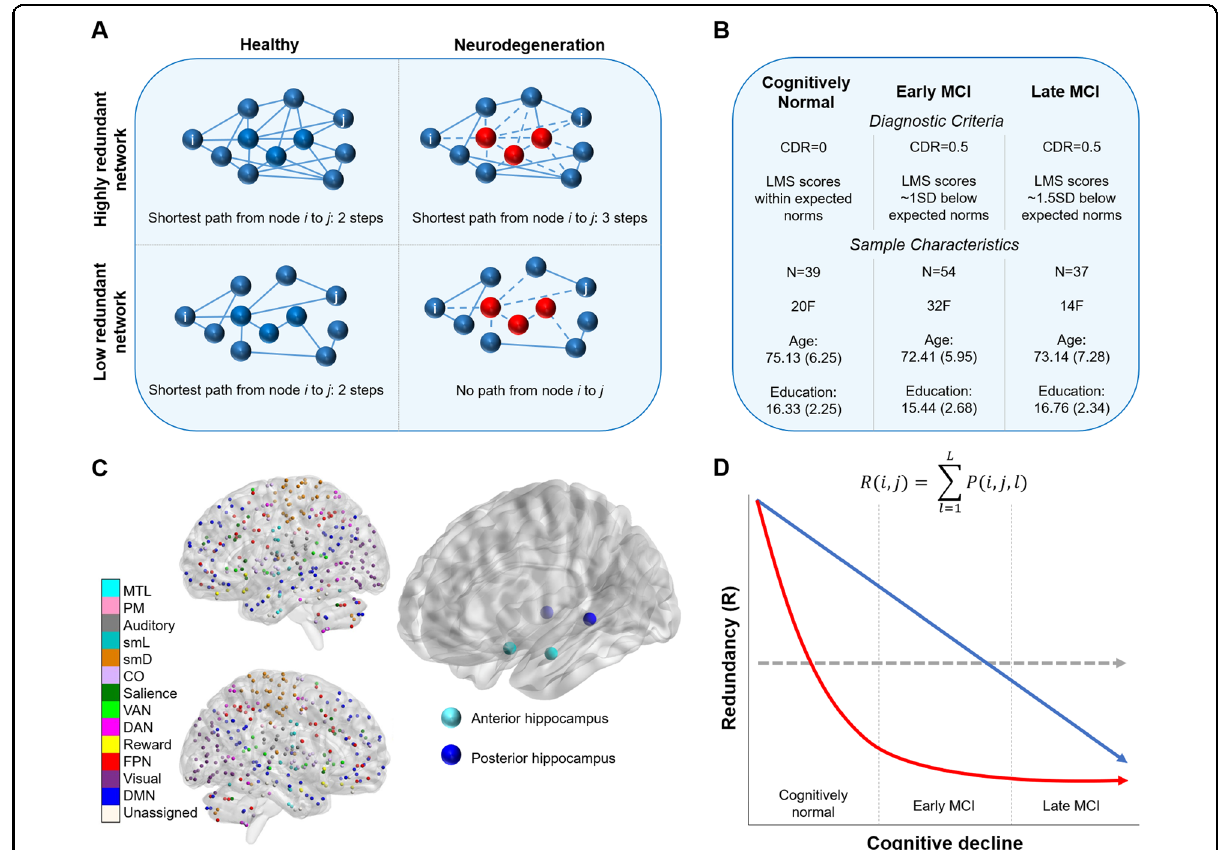
Fig. 1 Study design and hypotheses. A Examples of networks with high and low redundancy. The shortest path between nodes i, j do not differ between high and low redundancy in a healthy state. In the case of neurodegeneration (red nodes), a highly redundant network retains a path between nodes i, j , whereas there are no paths between nodes i, j in a low redundancy network. B Sample characteristics of the included subjects. C Representation of the functional parcellation used in the current study made up of 300 nodes representing cortical, subcortical, and cerebellar regions 26 . The four hippocampal nodes are shown next to the full atlas parcellation, representing anterior (cyan) and posterior (blue) hippocampus. D Three hypothesized relationships between redundancy and cognitive decline. There could be no relationship between redundancy and cognitive decline (gray line), a linear relationship such that redundancy declines linearly across healthy aging, early MCI, and late MCI states (blue line), or a nonlinear relationship, such that redundancy declines between healthy aging and MCI, but plateaus in MCI (red line). Redundancy equation presented above hypothesized relationships, in which redundancy, R , of node pair i,j is represented by the sum of all paths between i,j at length l , up to a maximum path length, L